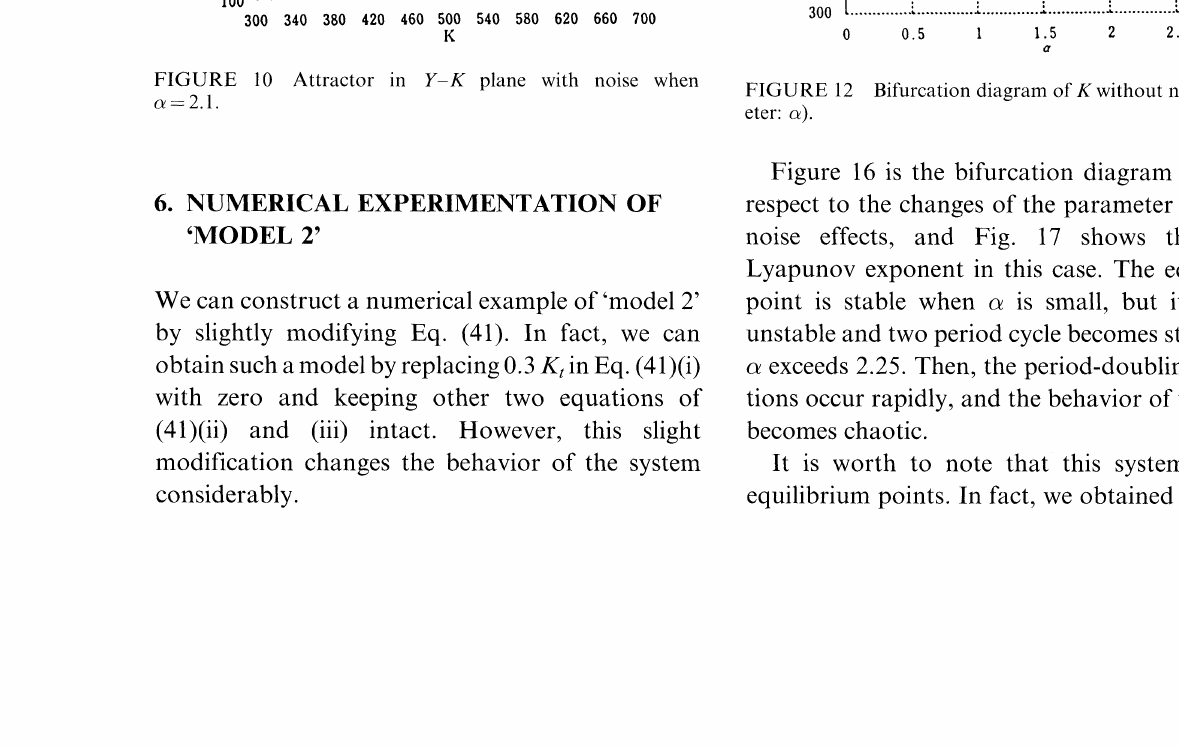
FIGURE 9 Attractor in Y-K plane without noise when c 2.2.